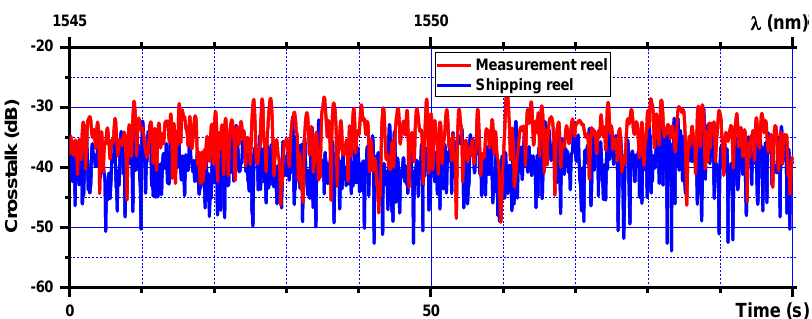
Figure 15. Crosstalk variations with laser wavelength scanning for the fiber of 1540 m length on shipping and measurement reels.